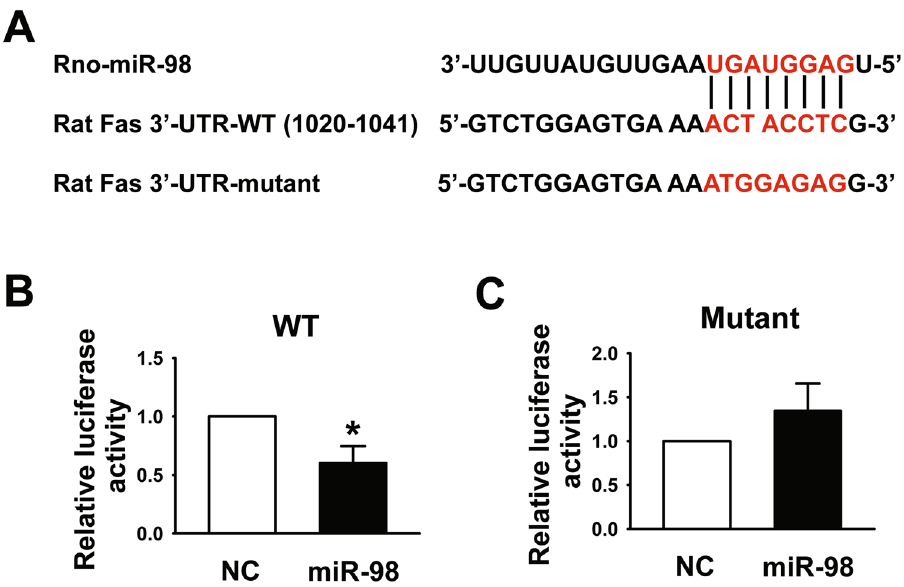
Figure 5. Fas was the target gene of miR-98. ( A ) The bioinformatic analysis showed that miR-98 had a binding site in the 3 ′ -UTR of Fas mRNA and the mutation of the putative binding site was designed. ( B ) and ( C ) Dual Luciferase reporter assay was performed by co-transfection of luciferase reporter containing WT or mutant 3 ′ - UTR of rat Fas with miR-98 mimic into HEK293T cells. MiR-98 overexpression markedly decreased the relative luciferase activity in the WT 3 ′ -UTR but not mutant 3 ′ -UTR of Fas mRNA. n = 6. * P < 0.05 versus NC